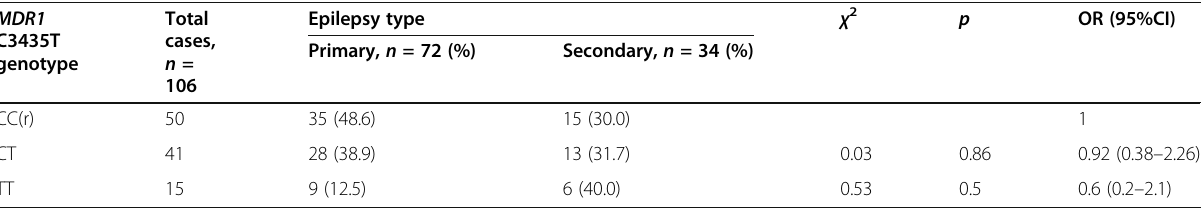
No statistically significant association was found between epileptic types (primary and secondary) and MDR1 C3435T genotype distribution